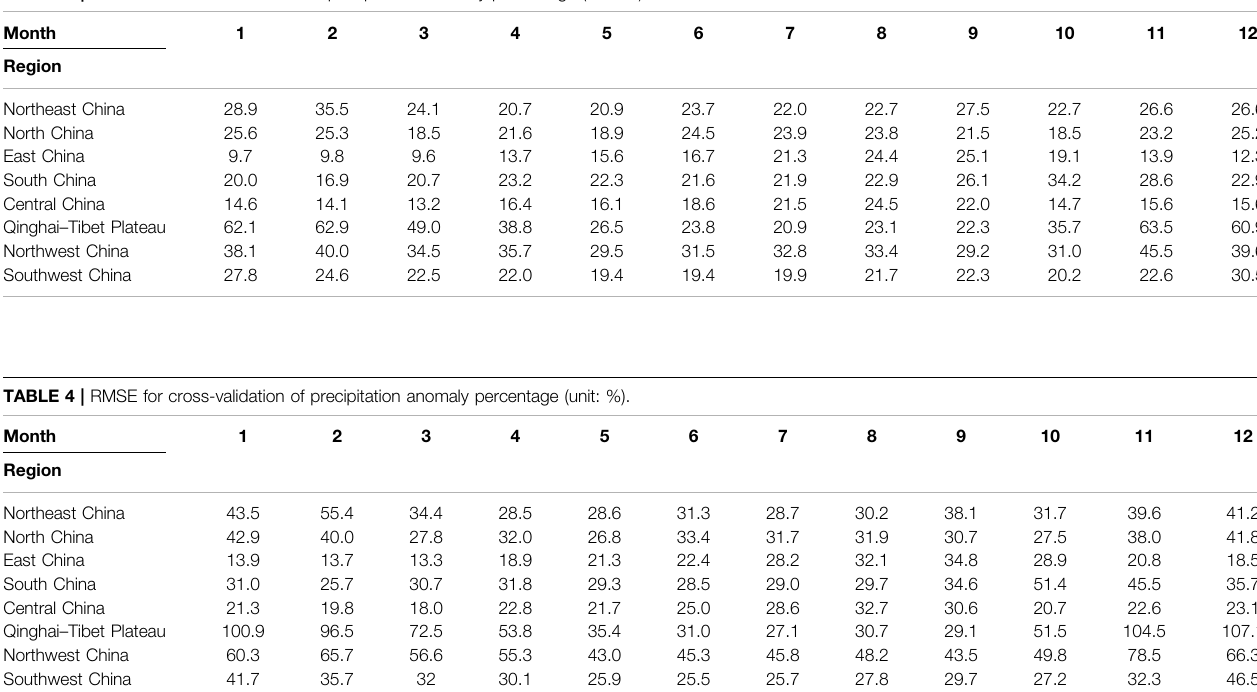
TABLE 3 | MAE for cross-validation of the precipitation anomaly percentage (unit: %).